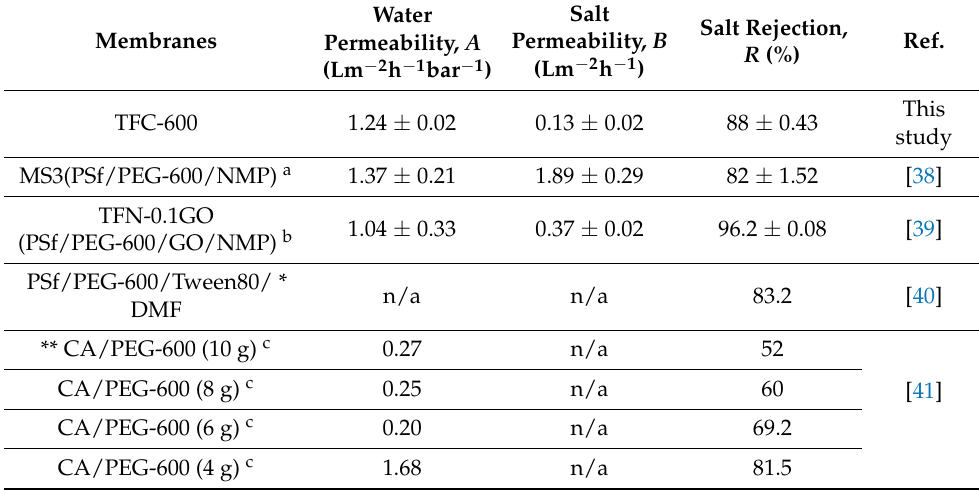
Table 4. The A , B and R values of the TFC-600 membrane and other TFC membranes with PEG 600 found in the